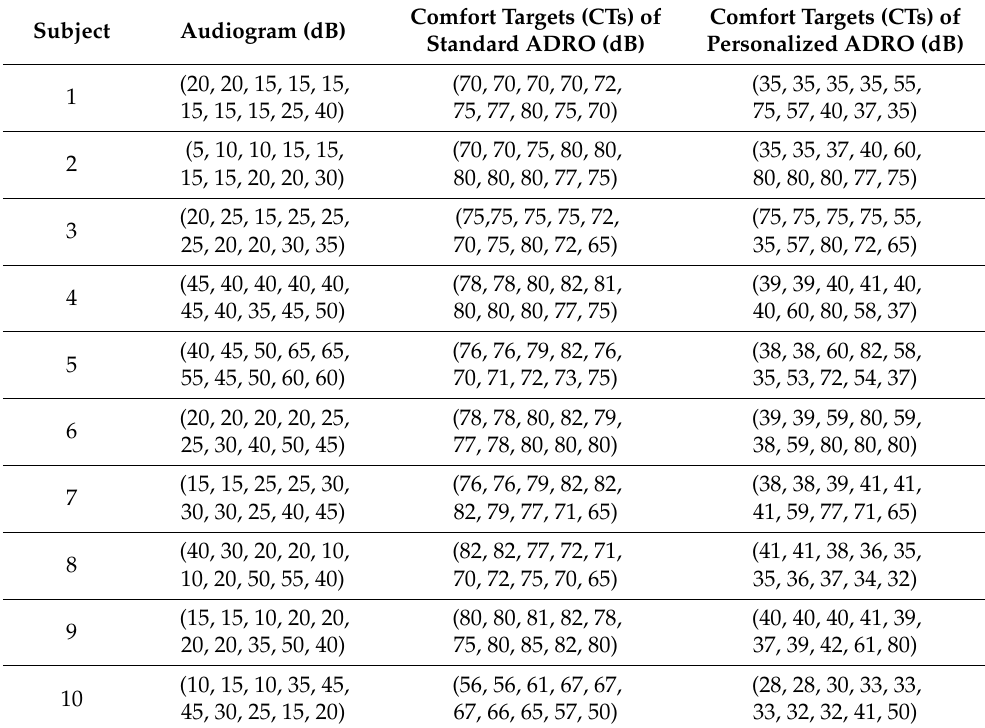
Table 1. Personalized ADRO comfort targets after online training by